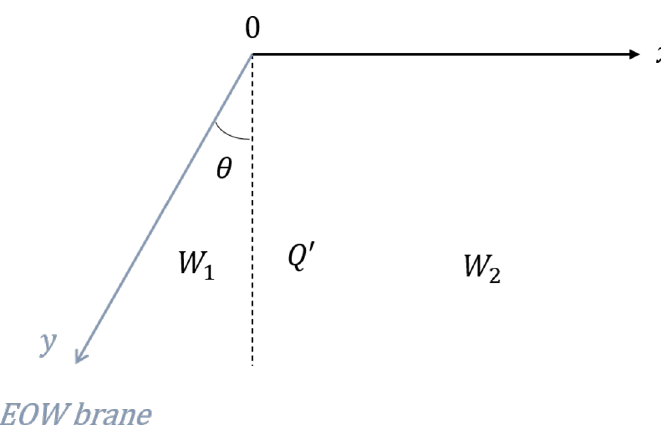
Figure 2 . Bulk decomposition by inserting an imaginary boundary Q 0 .